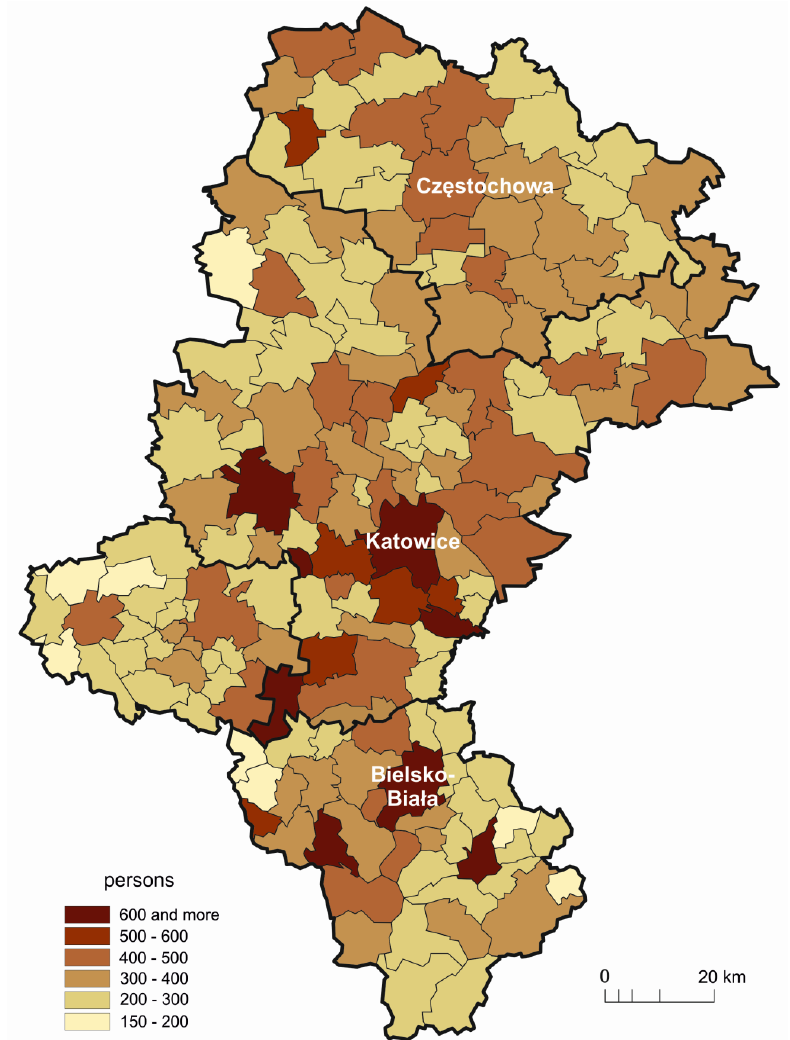
Fig. 3. Number of employed persons per 1,000 inhabitants of the Silesian voivodeship in 2010 (after Sitek et al.,